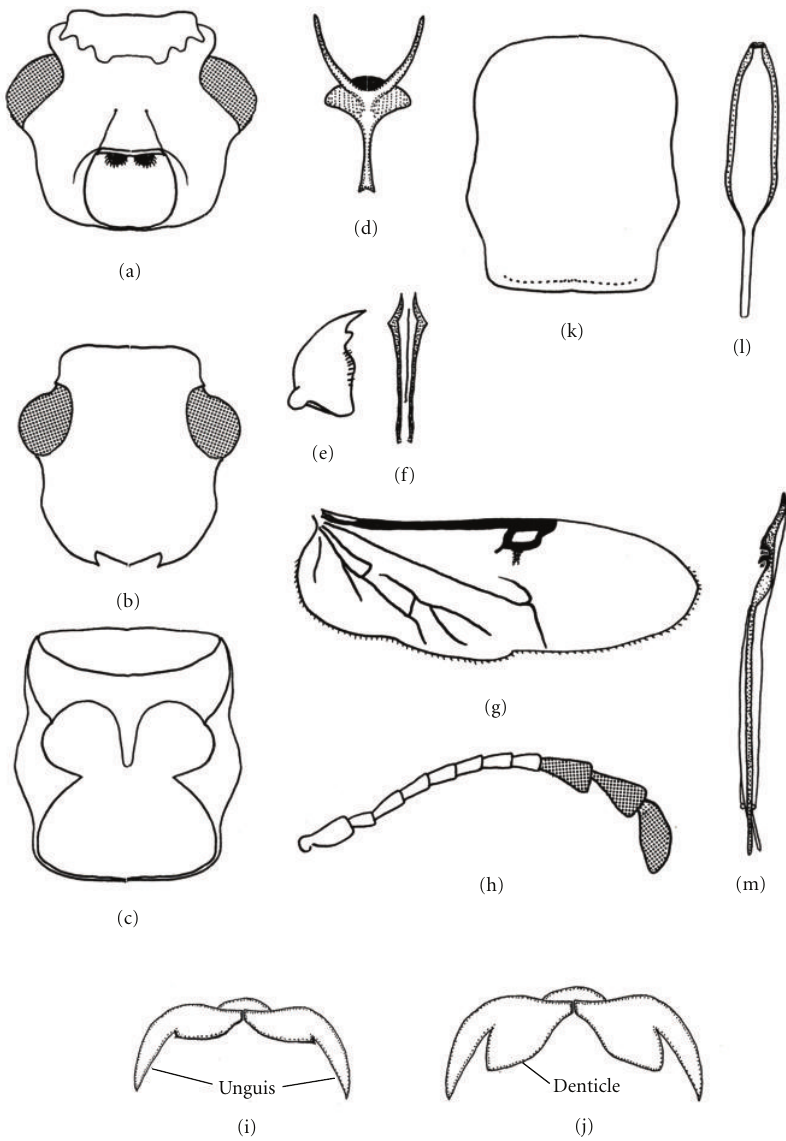
Figure 15: Various organs. (a)–(h), and (k)–(m) Riotenerus fossipenne . (a, b) Head ((a) ventral, (b) dorsal). (c) Pronotum (ventral), (d) Metendosternite. (e) Mandible. (f) Spiculum. (g) Metathoracic wing. (h) Antenna. (i) and (j) Generalized unguis ((i) without denticle, (j) with denticle). (k) Pronotum (dorsal). (l) Tegmen. (m) Phallus.